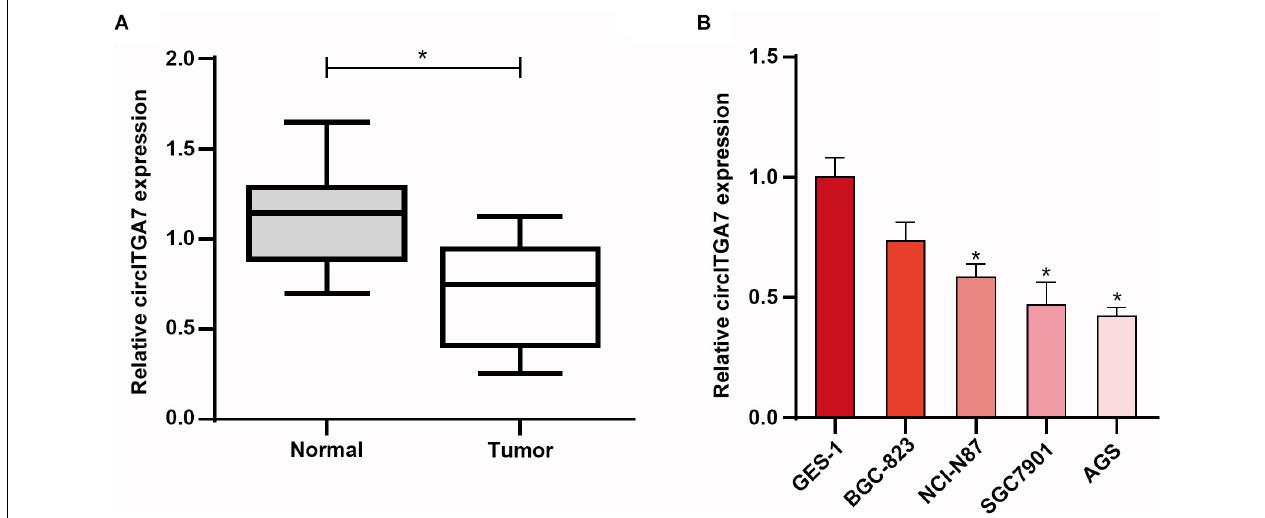
FIGURE 4 | The expression of circITGA7 was remarkably decreased in gastric cancer. (A) Compared to normal tissues, CircITGA7 expressed significantly lower in GC tissues * P < 0.05. (B) Expressions of circITGA7 in gastric tumor cell lines and gastric epithelial cell line * P <